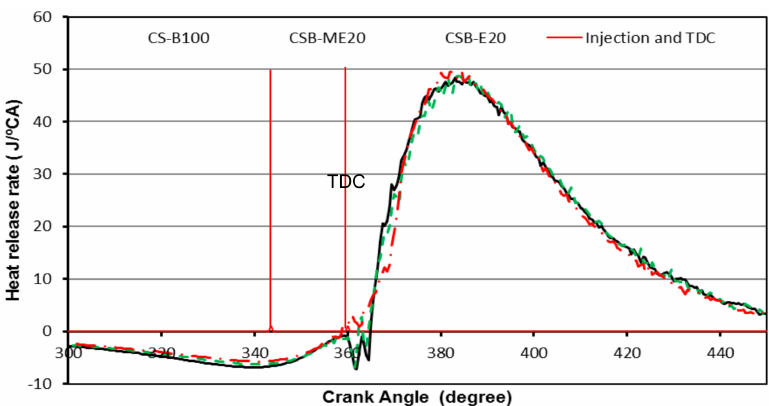
Figure 6. In-cylinder pressure at an engine speed of 2900 rpm.